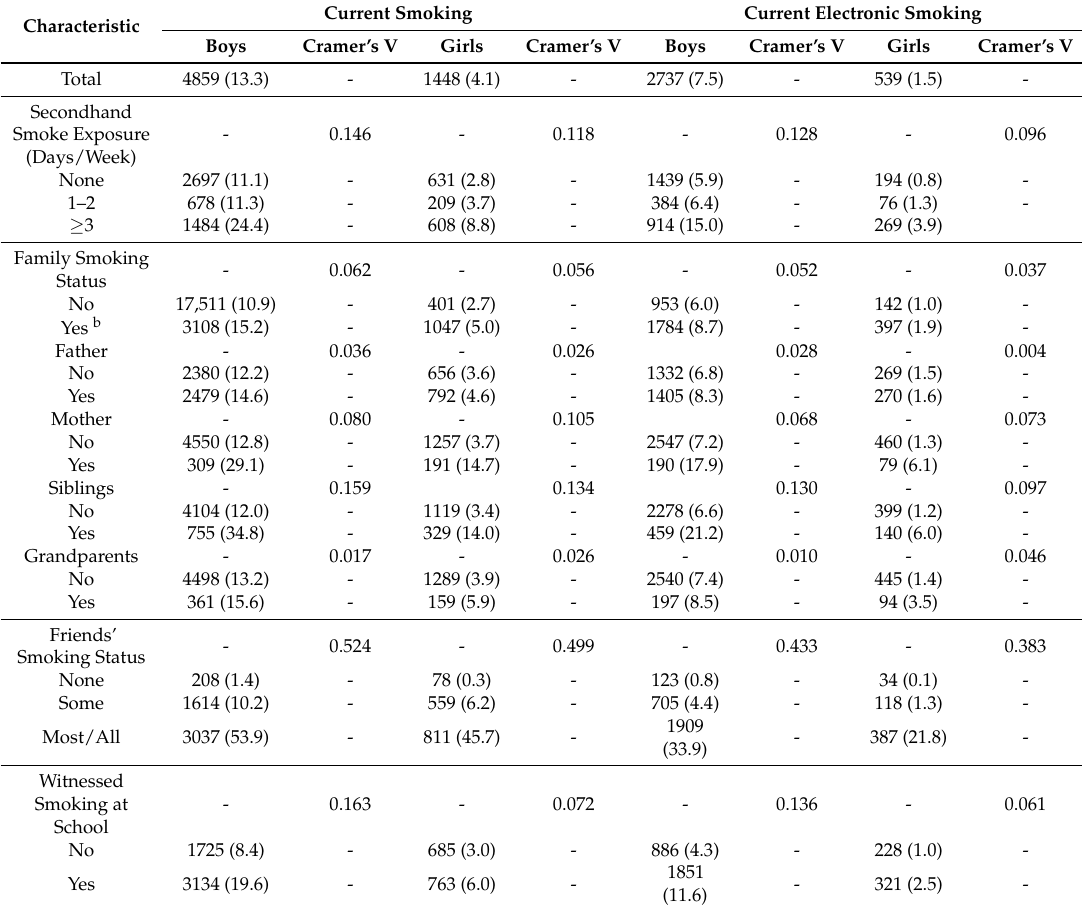
Table 2. Proportion of current smoking by family and friends’ smoking status a